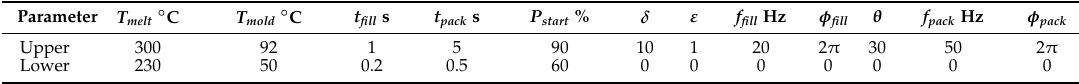
Table 7. The boundary values of the design parameters .